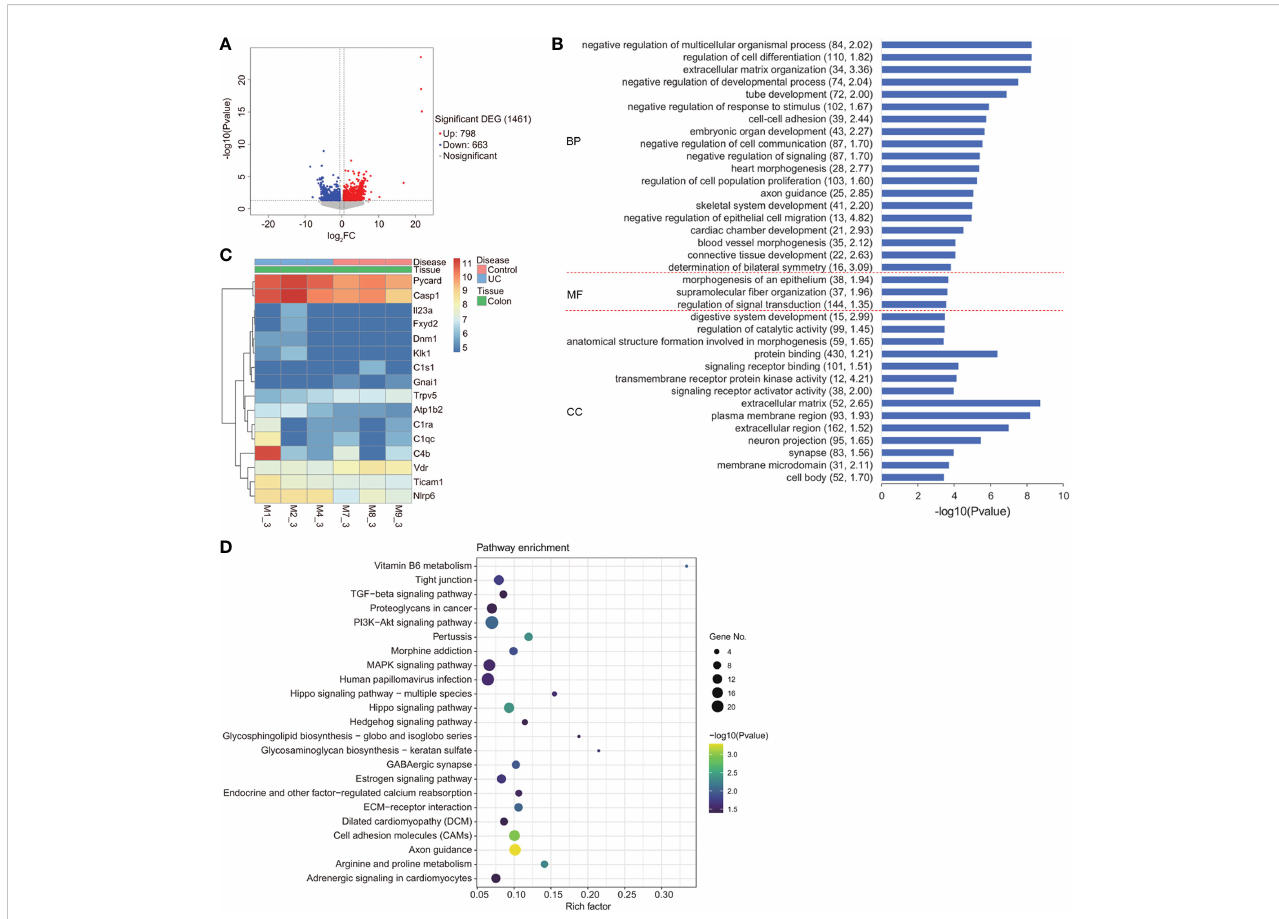
FIGURE 3 Gene expression pro fi le of DSS-induced UC in mice. (A) Volcano plot of differentially expressed genes. X axis: log 2 FC; Y axis: -log10 (FDR). Red represents upregulated genes, and blue represents downregulated genes. (B) GO term analysis of BP, MF, and CC for the genes. The minus logarithm of the P value (x-axis) indicates the signi fi cance of the gene set belonging to prede fi ned categories under the coexpression network gene background. The y-axis represents each GO category. (C) A heatmap depicting the gene expression pro fi les of vitamin B6 metabolism and the pertussis signalling pathway in the colon of the DSS mouse model and healthy controls. X axis: sample name; Y axis: gene name. (D) Enriched upregulated and downregulated genes, as determined by KEGG pathway